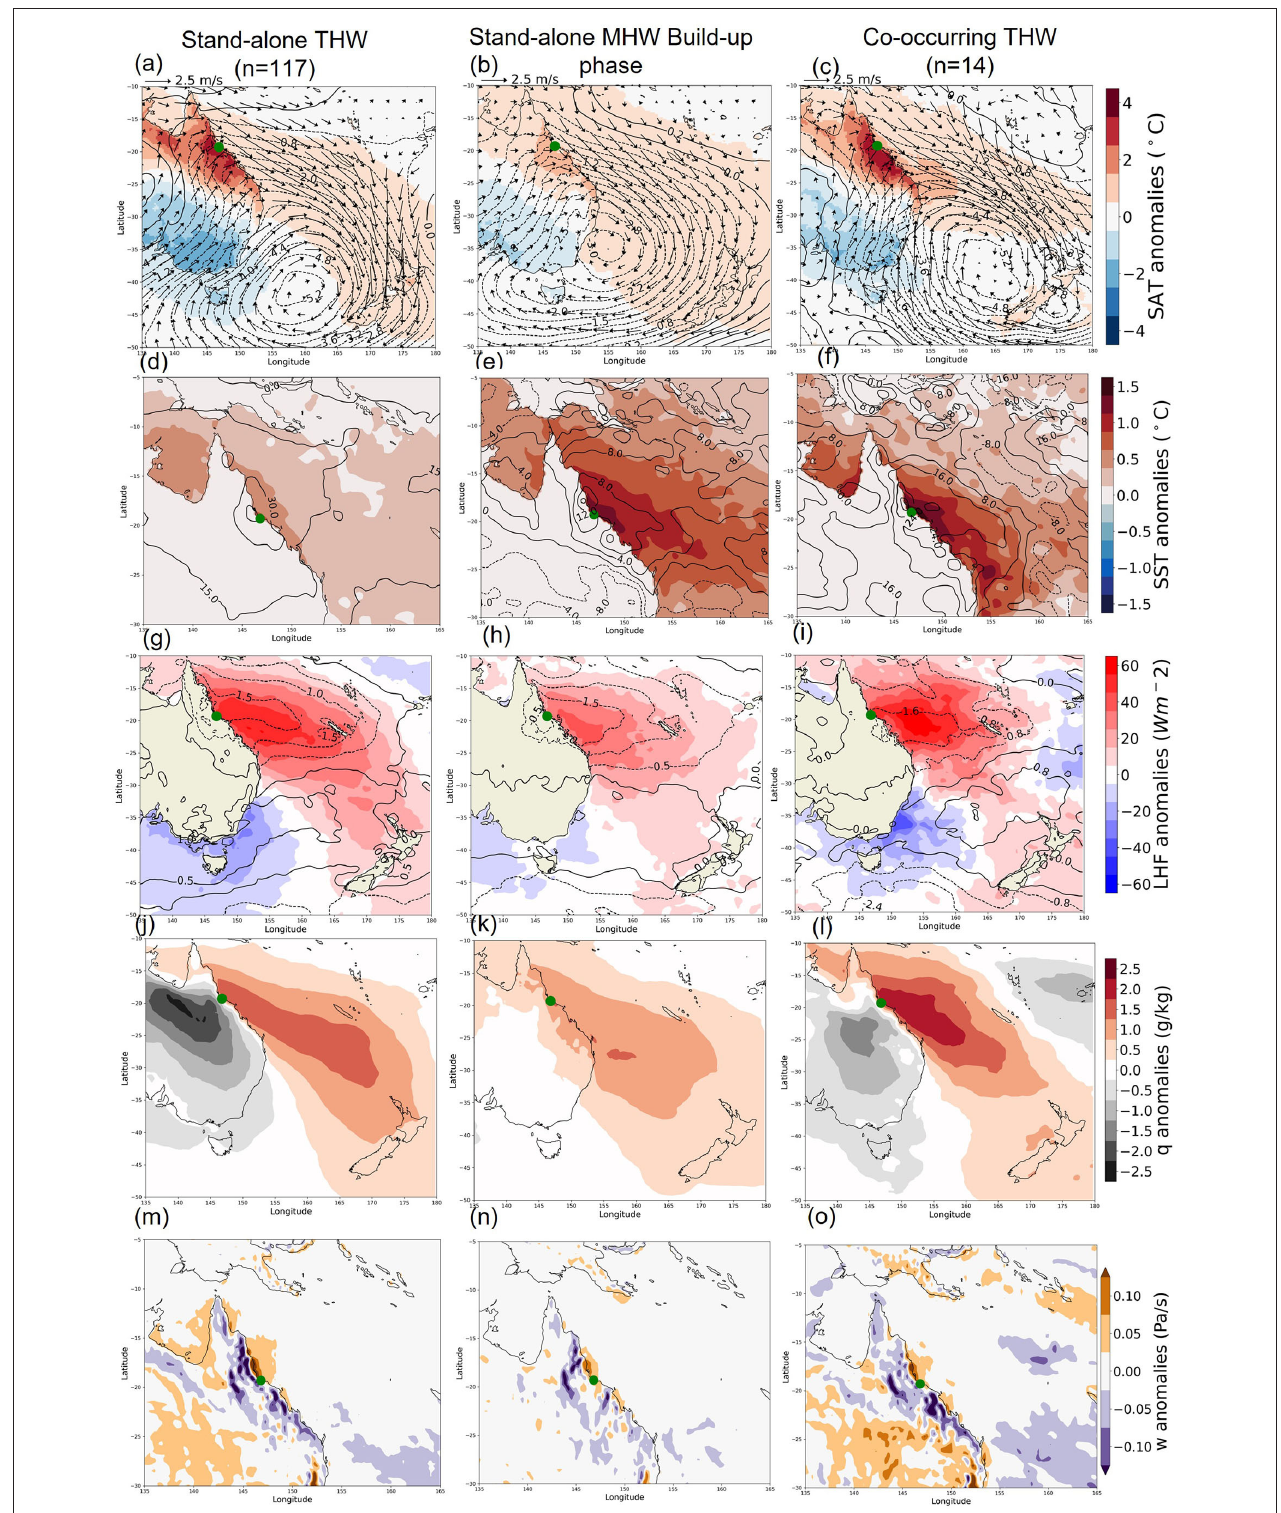
FIGURE 7 | Composite synoptic conditions for stand-alone THWs (left column), stand-alone MHW build-up (center) and co-occurring THW (right column) in Townsville. (a–c) show SAT anomalies (shaded), MSLP anomalies (line contours) and wind vectors. (d–f) show SST anomalies (shaded) and SWR anomalies (line contours). (g–i) show LHF anomalies (shaded) and windspeed anomalies (line contours). (j–l) show specific humidity anomalies. (m–o) show vertical velocity anomalies at 850 hPa. Negative LHF implies a flux of heat from the land/ocean surface to the atmosphere.